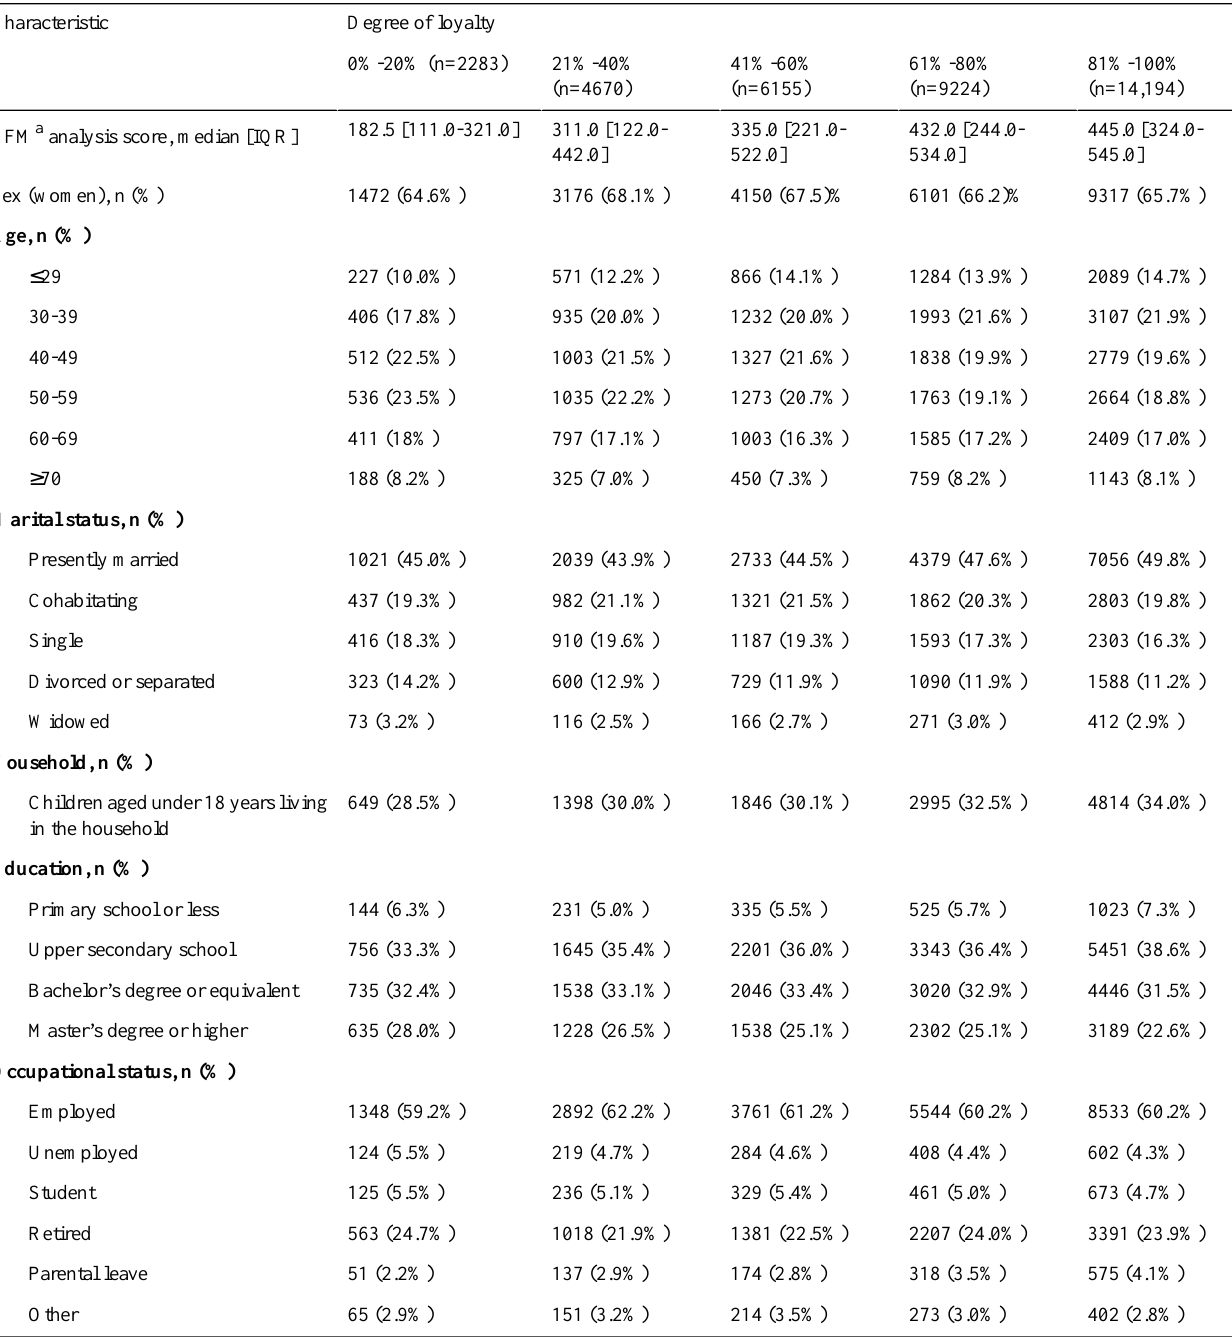
Table 3. LoCard participant characteristics and RFM scores across the five degree of loyalty groups. Degree of